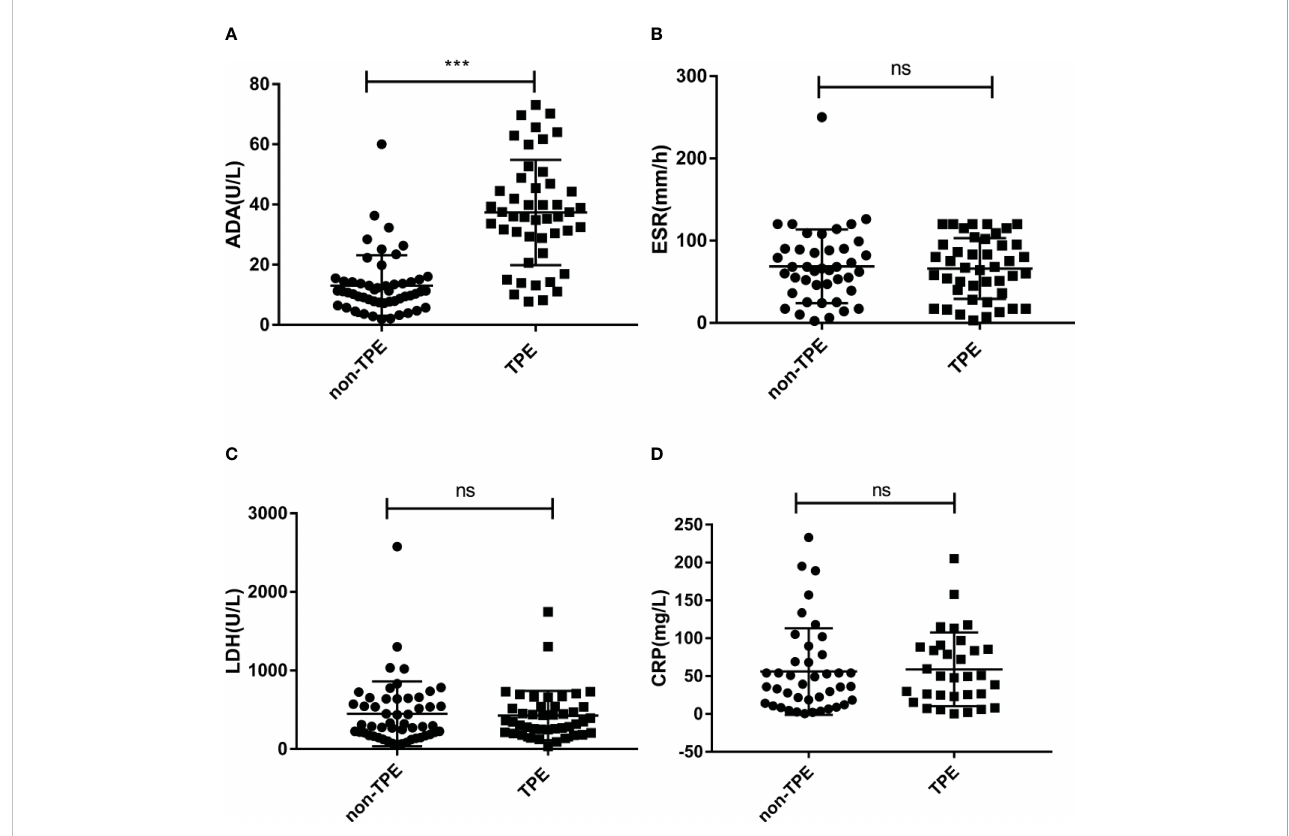
FIGURE 2 Concentration of ADA, LDH, ESR and CRP in TPE (N=47) and non-TPE(N=52) patients. Comparison of ADA (A) , ESR (B) , LDH (C) , CRP (D) level in TPE and those in non-TPE. ∗∗∗ P < 0.001, ns P >